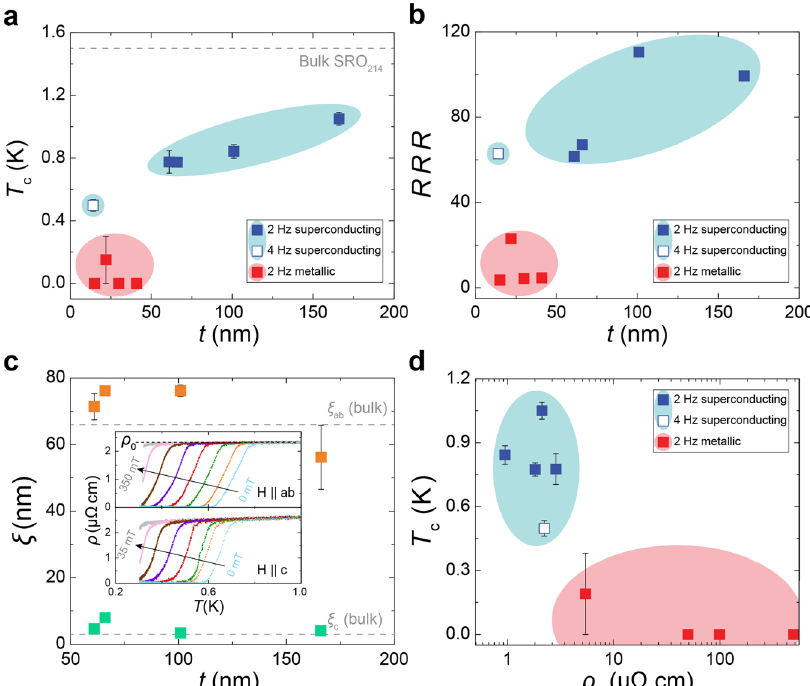
Fig. 2 Electronic transport properties of Sr 2 RuO 4 fi lms. a , b Thickness ( t ) dependence of the critical temperature T c ( a ) and residual resistivity ratio RRR ( b ). Filled squares correspond to fi lms grown with a laser frequency of 2 Hz and the hollow square at 4 Hz. c Superconducting coherence length in-plane ξ ab (orange squares) and out-of-plane ξ c (green squares) for multiple fi lms versus t , determined from resistivity versus temperature measurements with a magnetic fi eld applied along the ab-plane or the c -axis directions, respectively. d T c versus residual resistivity ρ 0 for superconducting and metallic fi lms marked as in ( a ) and ( b ). In all plots, background shading indicates a full superconducting transition (blue) or metallic (red) behaviour at low temperatures with or without incipient